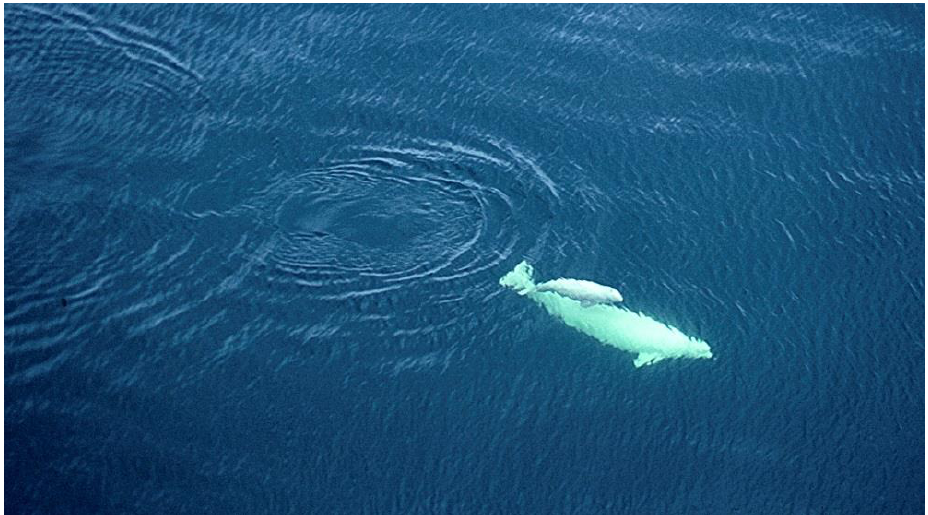
Fig. 2: Beluga and calf. (Photo: R. E. A.